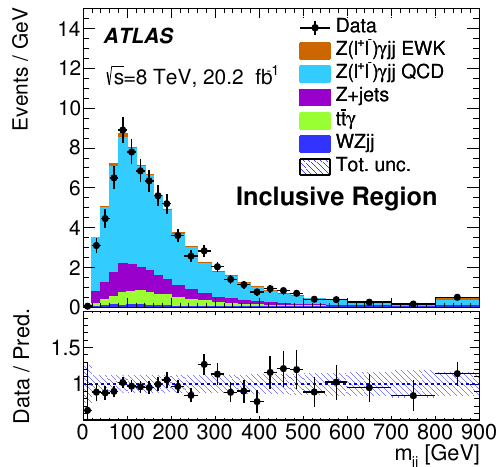
Figure 4 . Distributions of the dijet invariant mass of the two leading jets for the electron and muon channels added together in the inclusive region, for the data (black points), and for the signal process and various background components (coloured templates) before any (cid:12)t is done. The ratio of the data to the sum of all pre-(cid:12)t expected contributions (\Pred.") is shown below the histogram. The hatched blue band shows the systematic and statistical uncertainty added in quadrature (\Tot. unc.") in the signal and background prediction, while the error bars on the data points represent the statistical uncertainty of the data set. The number of events in each bin is divided by the bin width. The last bin also includes events beyond the range